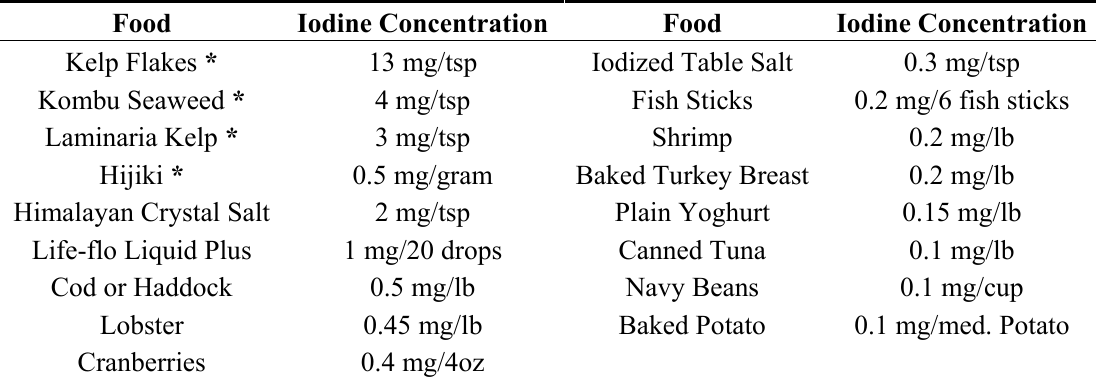
Table 3. Iodine concentrations in